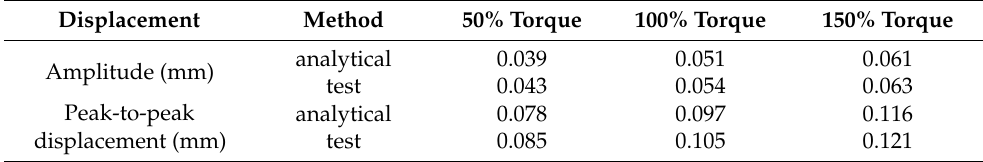
Table 5. Comparison between the analytical and test vibration of the carrier in the third stage. Displacement